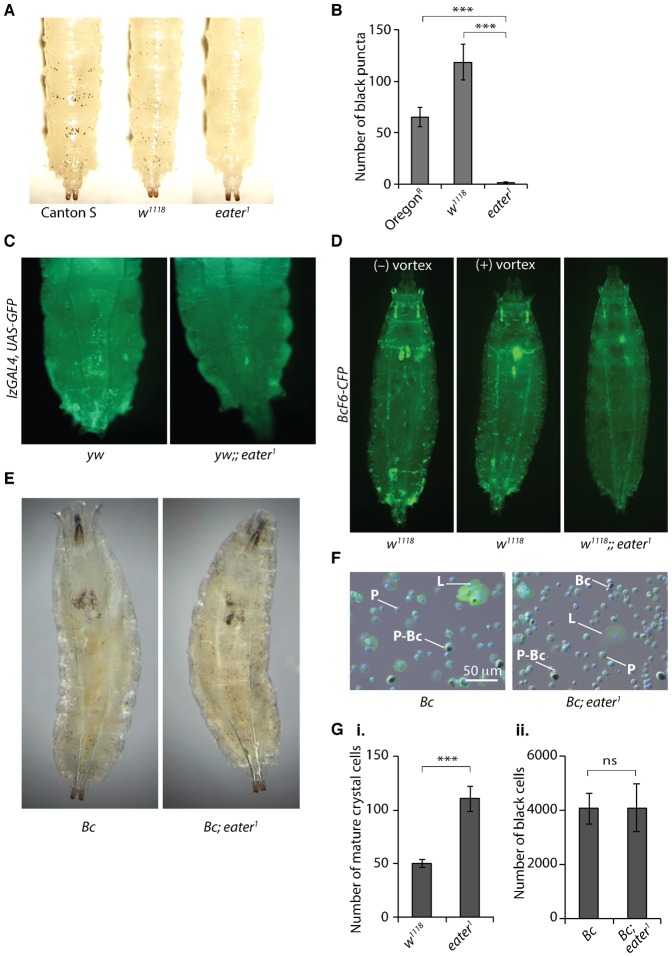
Sessile crystal cells are absent or almost absent in eater1 mutant larvae.(A) Heating (67°C, 30 min) reveals the presence of superficial crystal cells in the posterior abdominal segments of Canton S, w1118 and eater1 null larvae. The ventral larval surface is shown. (B) Circumferential black puncta counts from the three posteriormost segments A6, A7 and A8 of heated OregonR, w1118 and eater1 third instar larvae. (C) The crystal cell lineage marker lzGAL4, UAS-GFP reveals a near absence of sessile crystal cells in eater1 third instar larvae compared to controls. Dorsal view of the 5 posterior-most abdominal segments. (D) The mature crystal cell marker BcF6-CFP reveals a near absence of sessile crystal cells in eater1 mutant larvae compared to control w1118 larvae. Vortexing (1 min, speed 10) is sufficient to release many sessile crystal cells. Genotypes: w, EaterGAL4, UAS-2xeYFP; BcF6-CFP (P1+); msn9-mCherry and w, EaterGAL4, UAS-2xeYFP; BcF6-CFP (P1+); msn9-mCherry, eater1. (E) The numbers of black cells in Bc; eater1 mutant larvae are similar to the numbers in control larvae carrying the Bc gain-of-function mutation alone. Sessile black cells are present in Bc control larvae but absent in Bc; eater1 larvae. (F) AF488-phalloidin and DAPI-stained hemocyte fields from Bc control and Bc; eater1 third instar larvae. Plasmatocytes ‘P’ and lamellocytes ‘L’ are visible. Black cells may be anuclear black cells (Bc) or may coincide with plasmatocytes (P-Bc). Lamellocytes are a type of hemocyte induced by activation of the Drosophila cellular immune response. (G) (i) Cell counts of live crystal cells from hemocyte samples of w1118 and eater1 mutant larvae carrying the BcF6-CFP reporter transgene. Genotypes: w, EaterGAL4, UAS-2xeYFP; BcF6-CFP (P1+); msn9-mCherry and w, EaterGAL4, UAS-2xeYFP; BcF6-CFP (P1+); msn9-mCherry, eater1. (ii) Hemocytometry counts of black cells numbers from hemocyte samples of larvae carrying the Bc gain-of-function mutation either alone or in combination with the eater1 mutation. Genotypes: Bc and Bc; eater1.